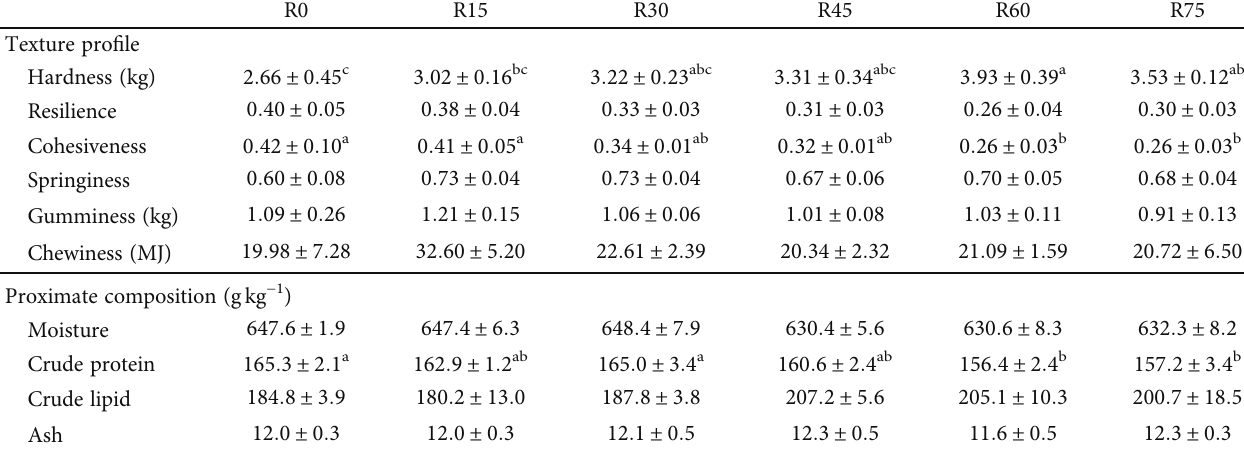
Table 5: Fillet texture pro fi le and proximate composition of Japanese eel fi llet fed with di ff erent replacement levels of DBSFLM. R0 R15 R30 R45 R60 R75 Texture pro fi